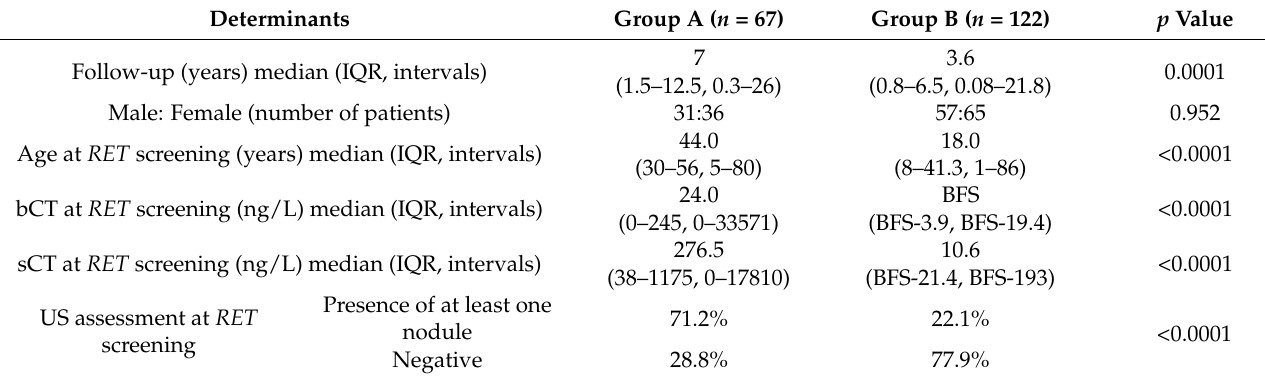
Table 1. Epidemiological, biochemical and US data of Group A and B. bCT: basal calcitonin, sCT: calcitonin upon pentagas- trin or calcium stimulation test, US: ultrasound, BFS: below functional